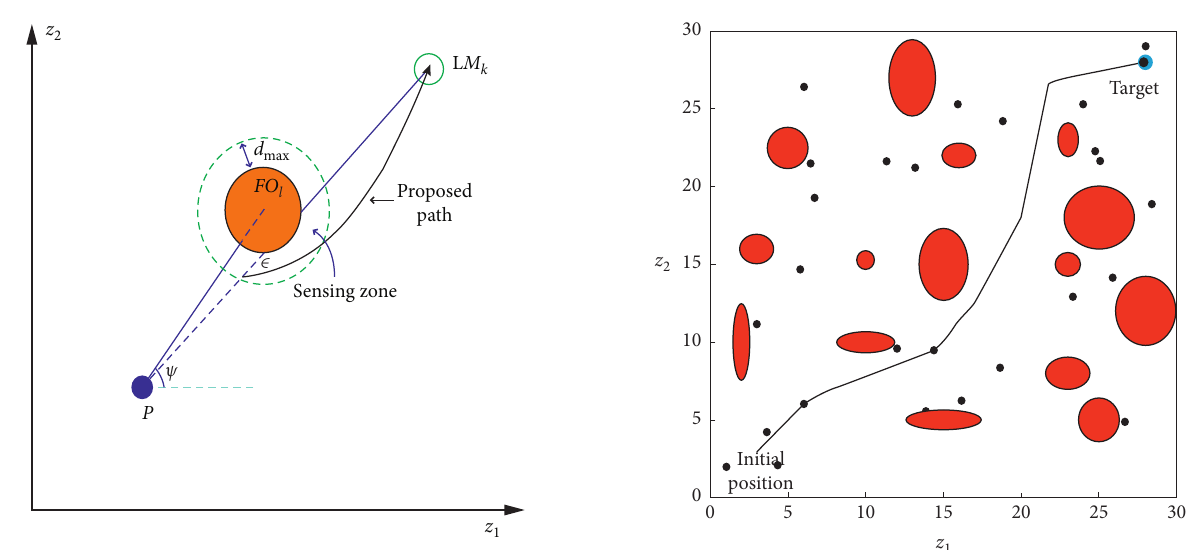
Figure 6: Schematic representation of the avoidance scheme with parameter d (modified from max